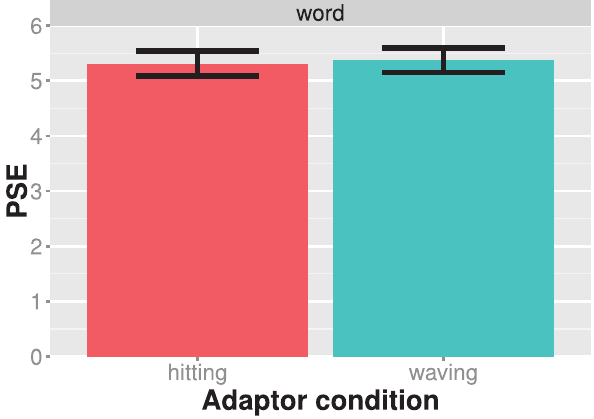
Figure 6. Results of experiment 4. The average PSE is shown for each adaptor condition separately. Larger PSE values indicate that the test stimulus showed more of a waving action. Bars always indicate one standard error of the